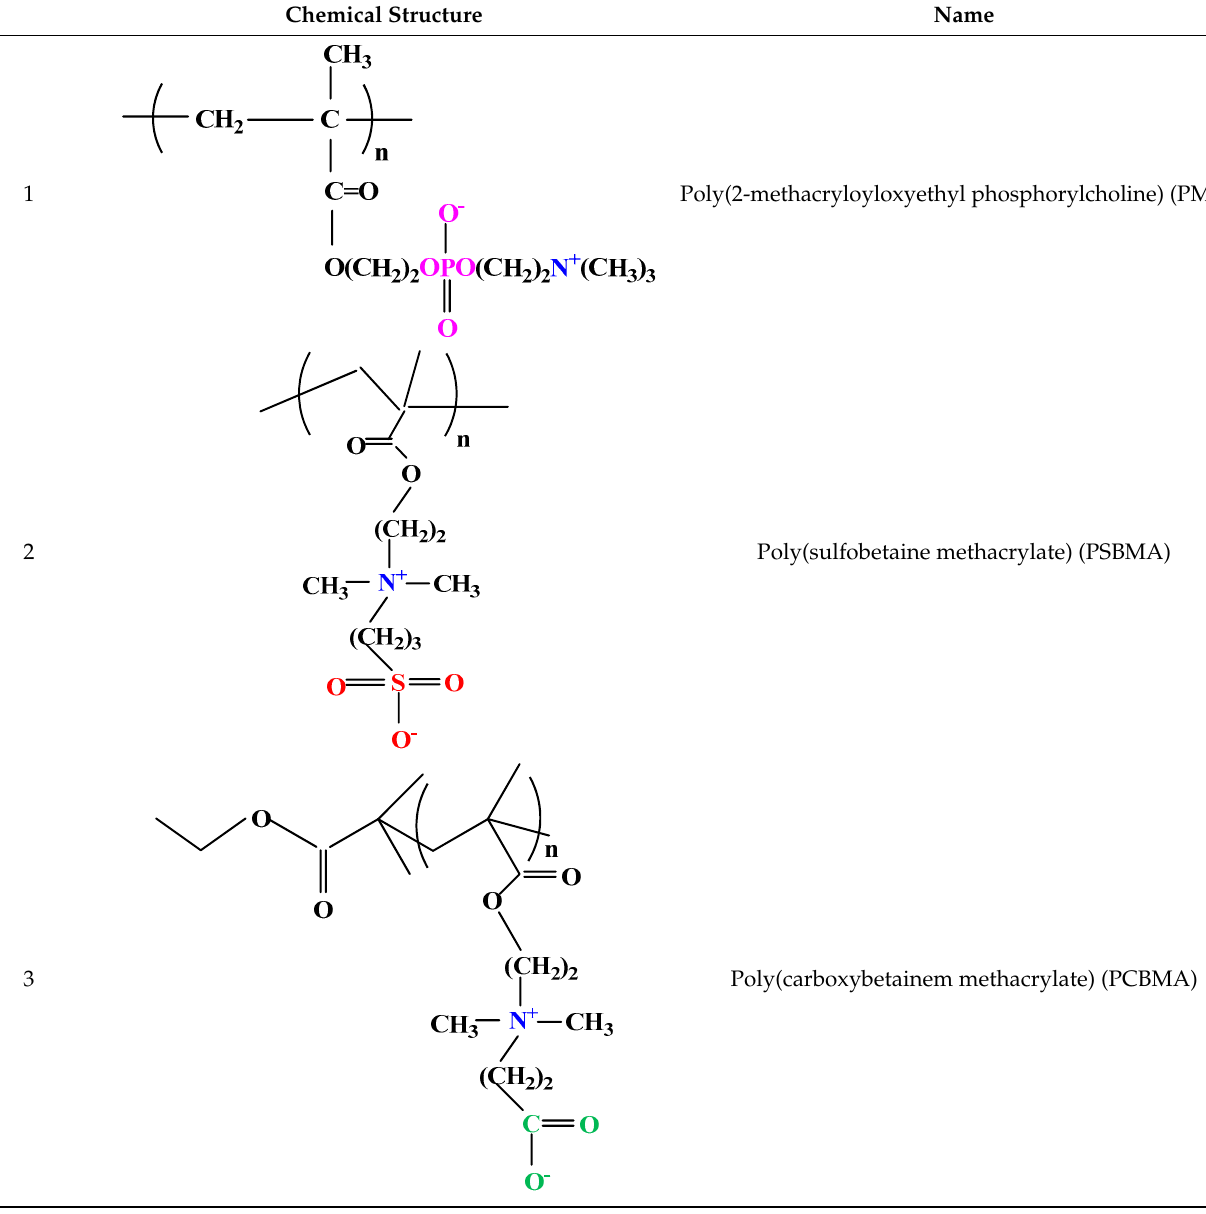
Table 2. The structure of most representative polybetaines used in drug delivery systems. Chemical Structure